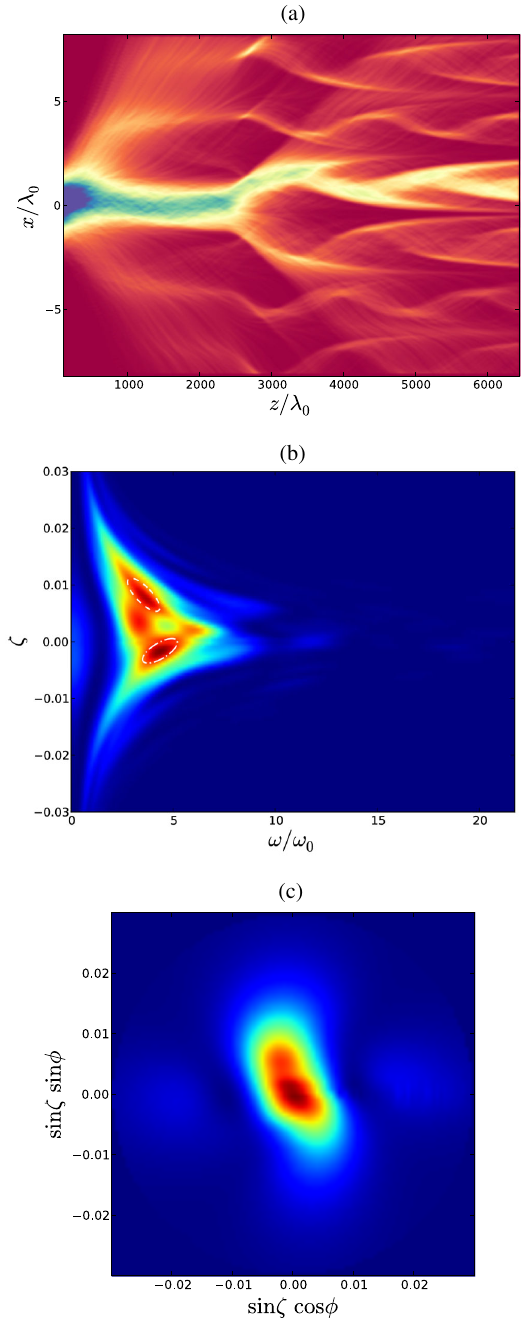
FIG. 7. Propagation of electrons injected obliquely into the optical lattice, followed by a KICK (a). Angular-spectral distri- bution of coherently emitted energy in the (cid:12) ¼ (cid:8)= 2 plane (b) and its angular distribution integrated over the frequency